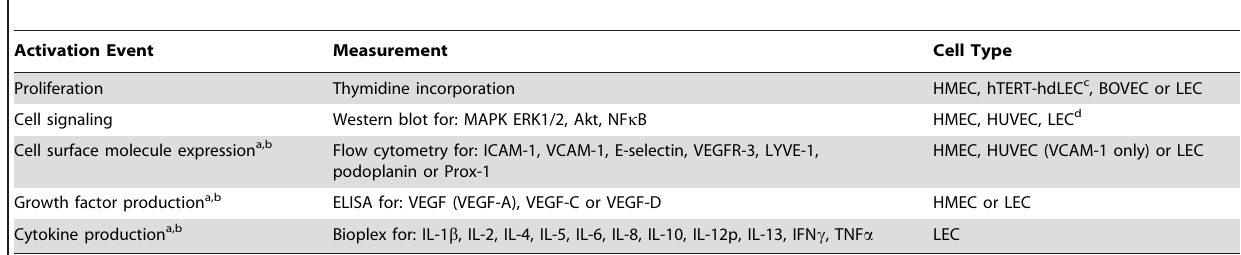
Table 2. Incubation of LECs with Brugia ES fails to induce cellular activation as measured by a variety of parameters.